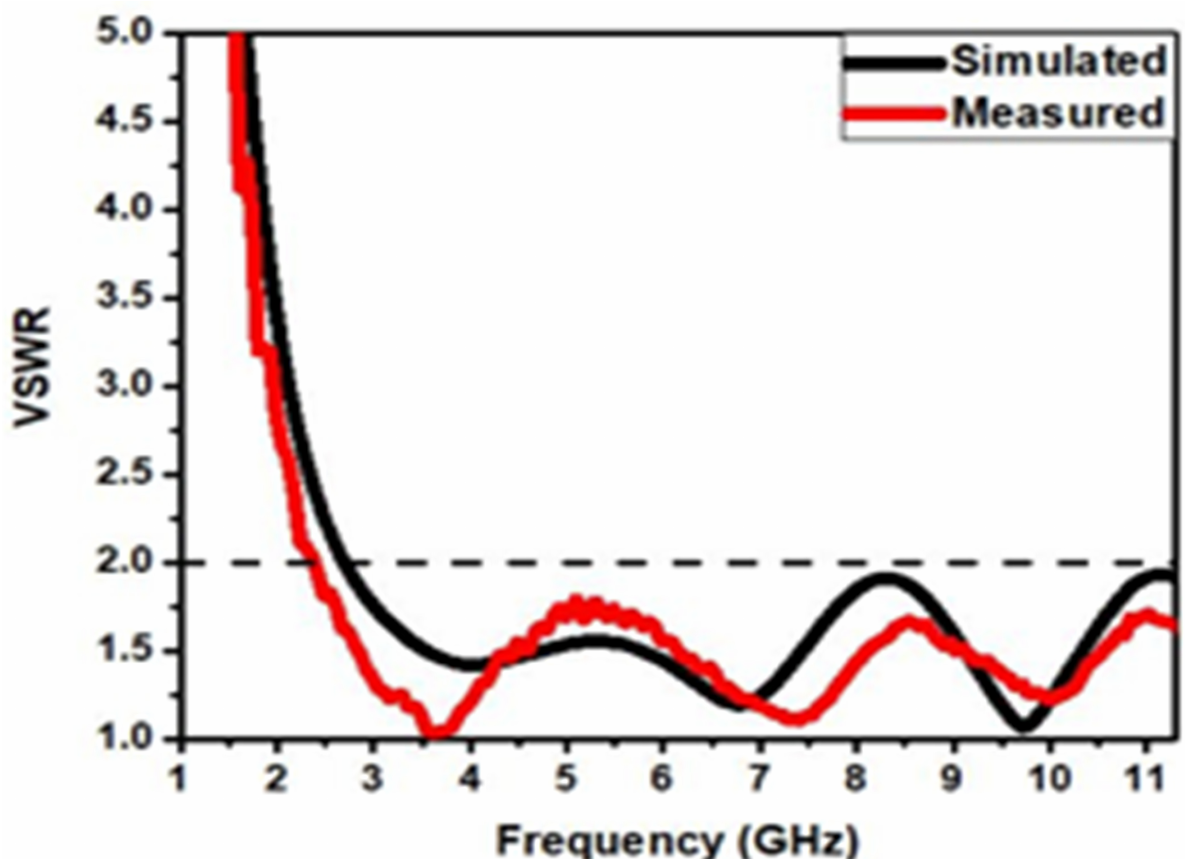
Figure 10. VSWR, simulated and measured.